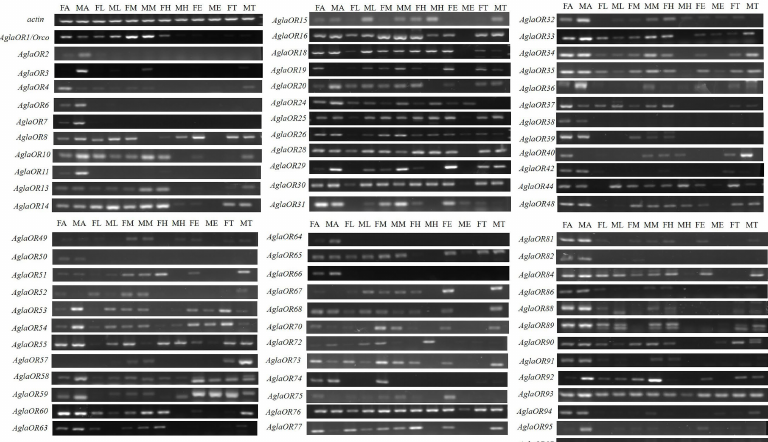
Figure 3. Expression profiles of AglaORs revealed by RT-PCR analysis of different adult tissues. FA, female antennae; MA, male antennae; FL, female leg; ML, male leg; FM, female mandibular whisk- ers; MM, male mandibular whiskers; FH, female head; MH, male head; FE, female external genitalia; ME, male external genitalia; FT, female thorax; MT, male thorax. Actin was used as the reference gene for each cDNA template. The intensity of the band is indicative of the expression level of the gene in different tissues. To confirm the results of RT-PCR, we used RT-qPCR to conduct relative quantitative expression analysis of the twenty-three ORs with high antennal expression in different sex adult tissues. Sixteen ORs showed significant male-biased expression ( AglaOR6/7/25/31/32/34/35/38/42/50/60/66/73/74/82/88 ) (Figure 4A); four ORs showed sig- Int. J. Mol. Sci. 2023 , 24 , x FOR PEER REVIEW nificant female-biased expression ( AglaOR19/33/86/91 ) (Figure 4B); and three ORs showed significant antennal-biased expression ( AglaOR3/11/29 ). However, there were no signifi- cant differences in expression between the sexes (Figure 4C).